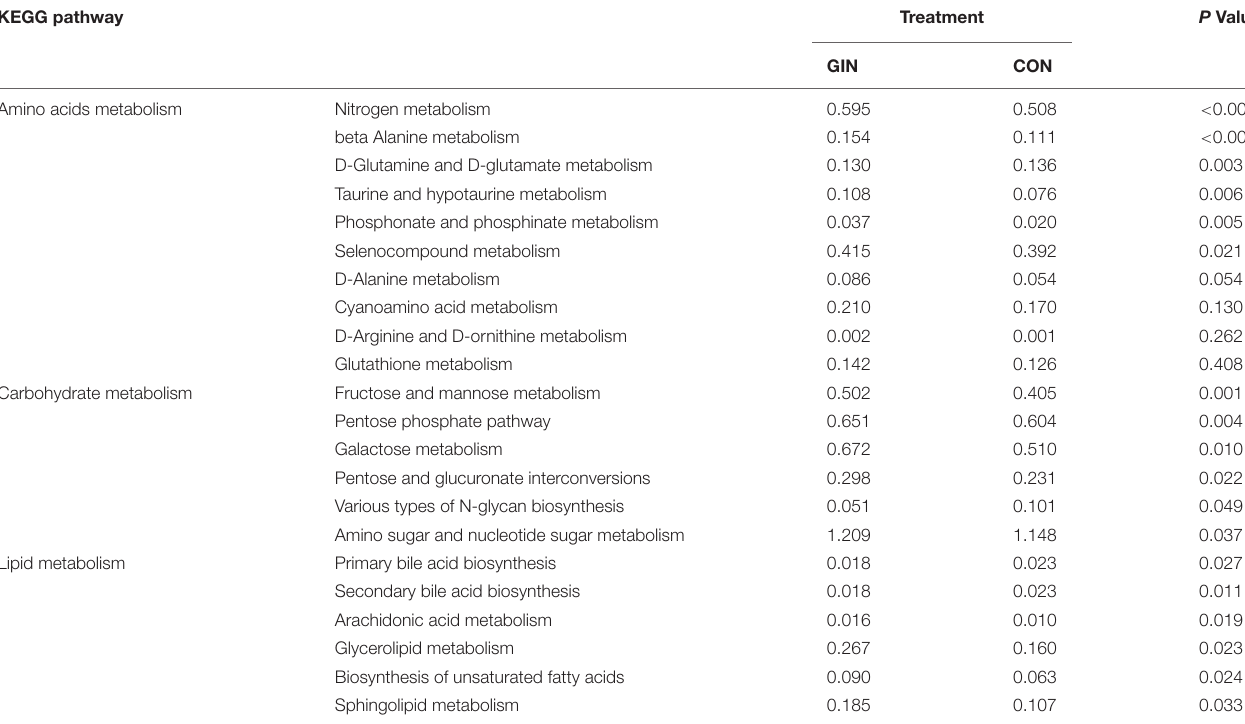
TABLE 5 | KEGG pathways of the duodenum microbiota significantly affected by Haemonchus contortus infection in lambs. KEGG